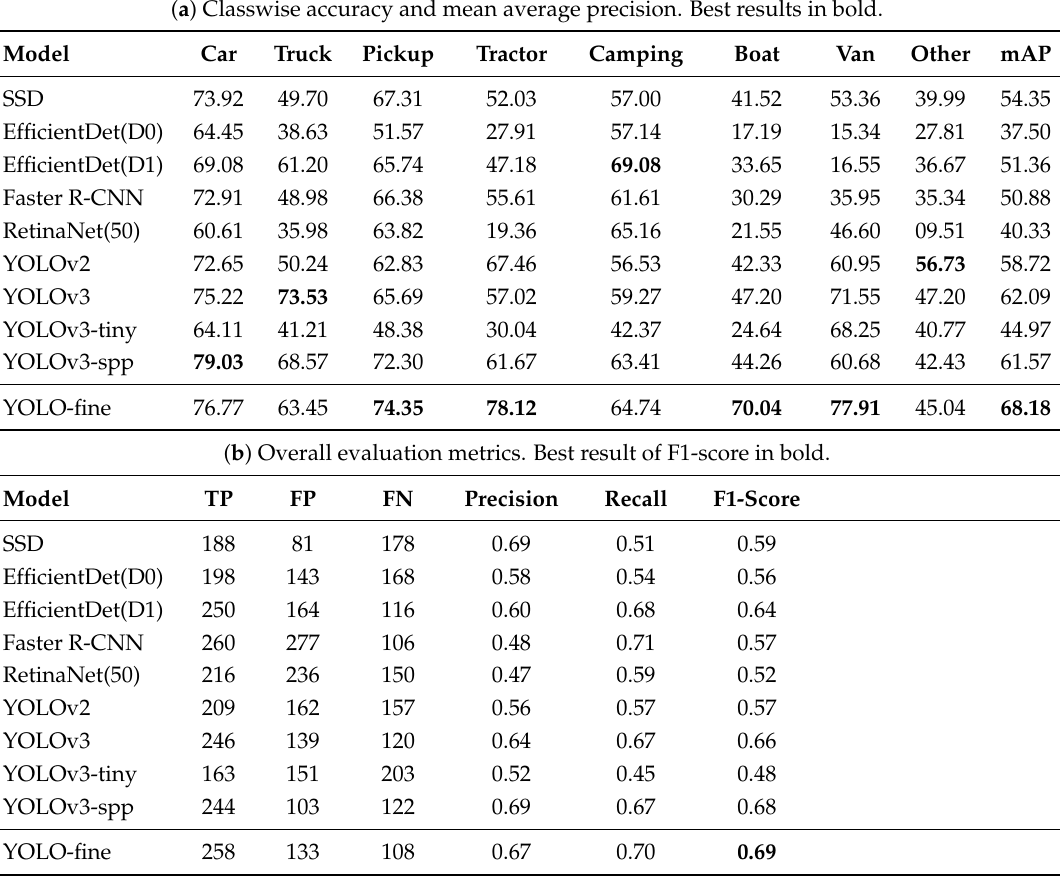
Table 3. Detection results on VEDAI512 (color